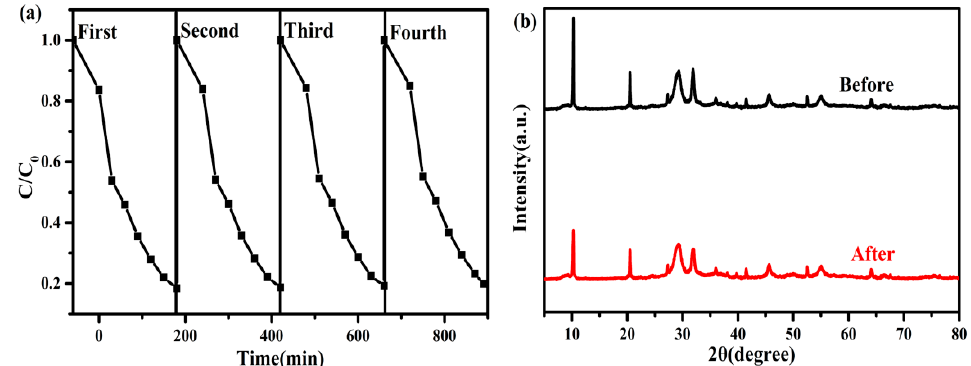
Figure 10. ( a ) Recycling measurements for Bi 3 O 5 I 2 , ( b ) XRD patterns of the Bi 3 O 5 I 2 before and after the cycling photocatalytic experiments.